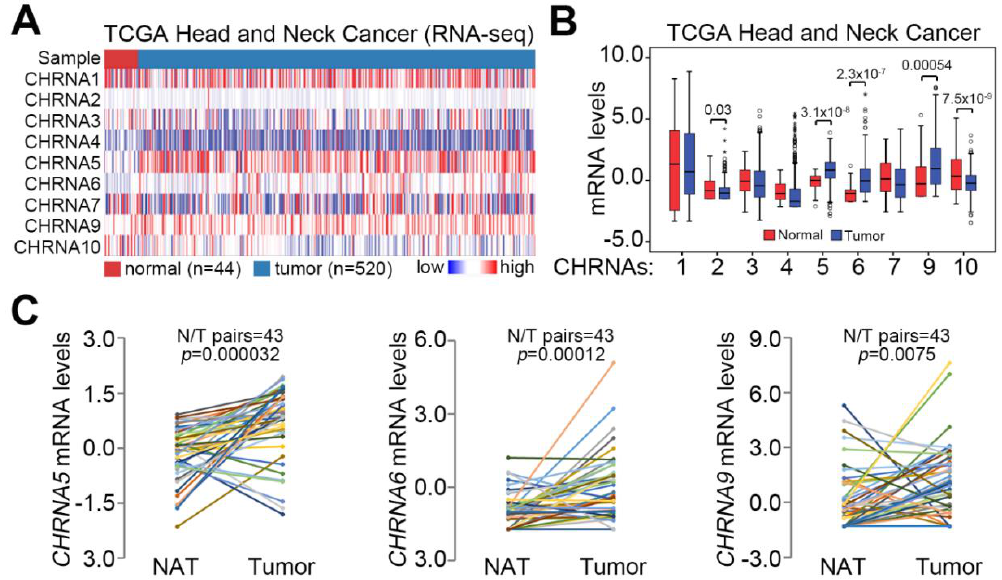
Figure 1: CHRNA5 is upregulated in primary tumors compared to normal tissues derived from head and neck cancer patients. ( A ) Heatmap for the transcriptional profiling of genes encoding nicotinic acetylcholine receptors (nAChRs) using the head and neck cancer database in The Cancer Genome Atlas (TCGA). ( B ) Boxplot of the mRNA levels of nAChRs in normal tissues and primary tumors derived from the TCGA head and neck cancer database. Statistical differences were analyzed by the Student’s t -test. ( C ) The mRNA levels of CHRNA5 , CHRNA6 , and CHRNA9 in normal adjacent tissues (NAT) and primary tumors from patients with head and neck cancer in the TCGA database. Statistical significance was evaluated by a paired samples t- test.